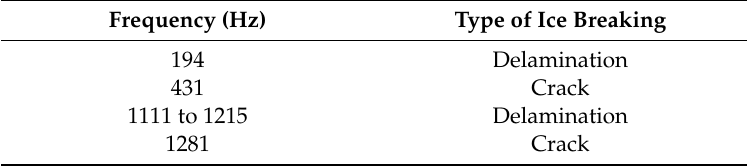
Table 3. Frequencies and type of ice breaking obtained in previous phase of the study